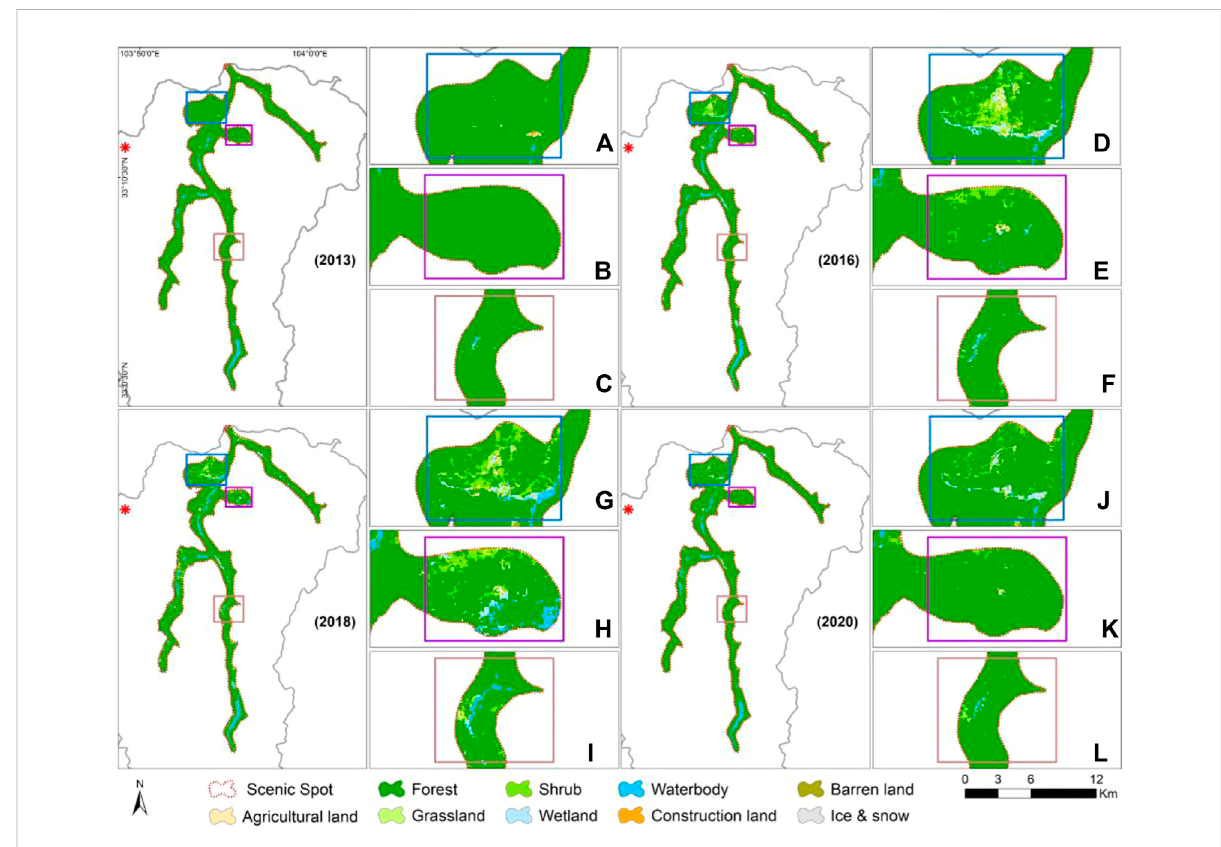
FIGURE 5 Spatial and temporal variation of main cover types in Jiuzhaigou Scenic Area: change in (A,D,G,J) shrub area, (B,E,H,K) wetland area, and (C,F,I,L) waterbody area.